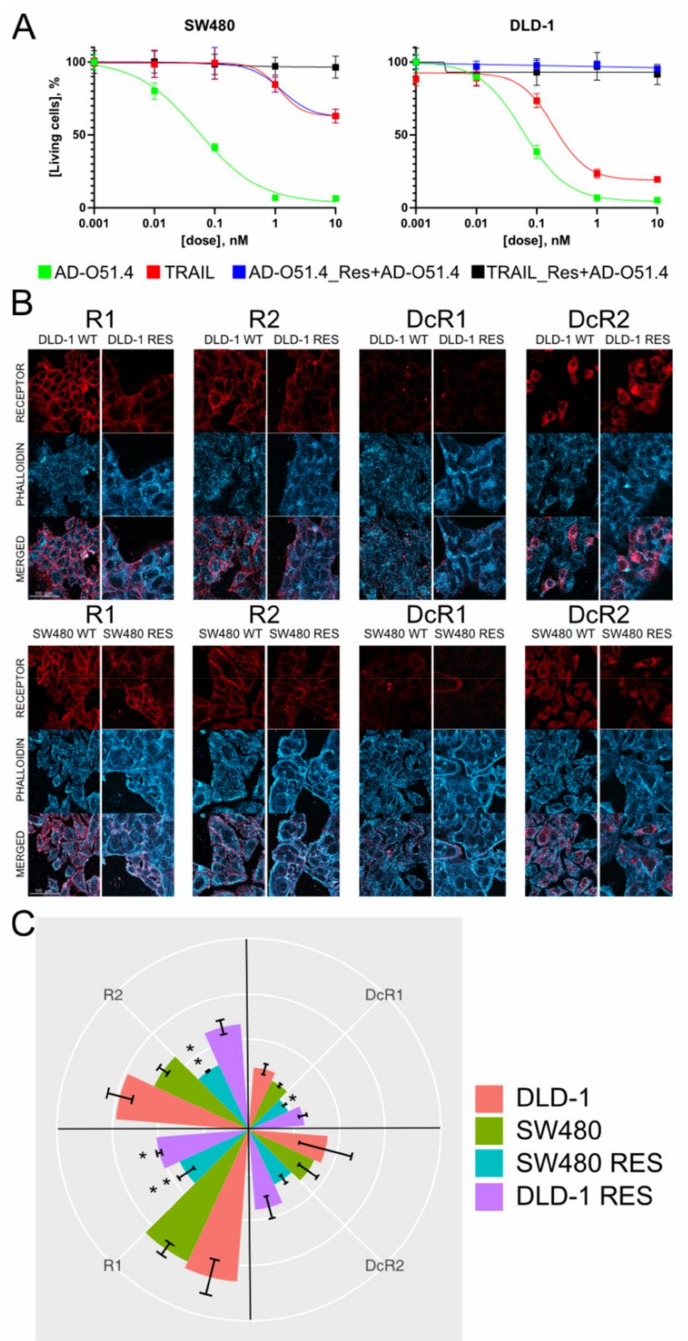
Figure 5. The SW480 and DLD-1 cell lines show the decreased cell surface expression of R1 and R2 TNF-related apoptosis-inducing ligand (TRAIL) receptors after acquiring resistance to AD-O51.4: ( A ) the development of AD-O51.4 resistance in SW480 and DLD-1 AD-O51.4 resistance was generated by culturing SW-480 and DLD-1 cells in the presence of increasing concentrations of AD-O51.4, starting at 0.05 nM. Resistance was examined using the MTT assay cells correlated with TRAIL resistance; ( B ) representative images of receptors in DLD-1 and SW480 cells wild type (WT) and the AD-O51.4-resistant variant (RES); ( C ) quantification of receptor density after the immunofluorescence staining of primary cell lines and cells with acquired resistance. Each bar represents the mean value of three measurements in three independent experiments. Error bars indicate the standard deviation. Differences between groups were evaluated using the Mann–Whitney U -test; * p < 0.05, ** p <